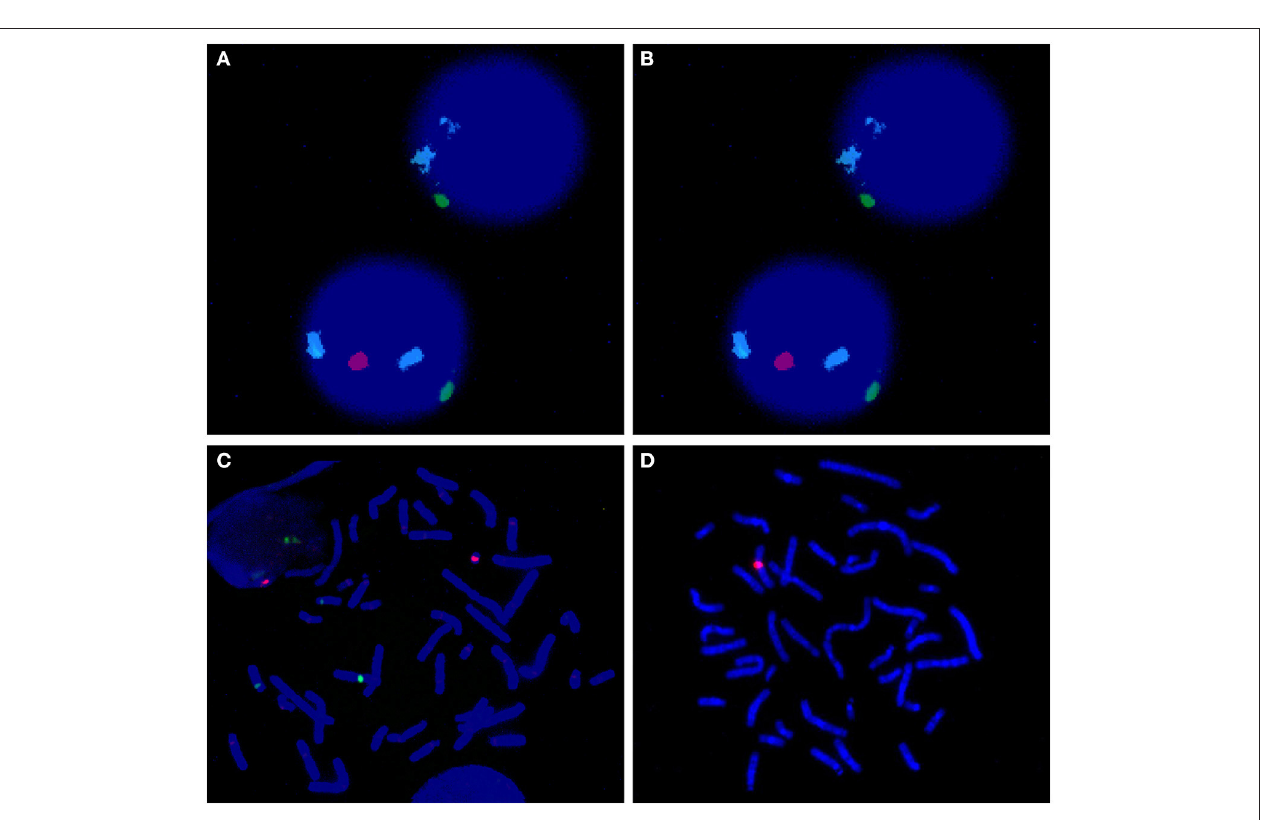
presented with AZF microdeletions (12). The clinical phenotype of 45,X/46,XY individuals is very broad and includes Turner females, varying degrees of genital malformations, and men